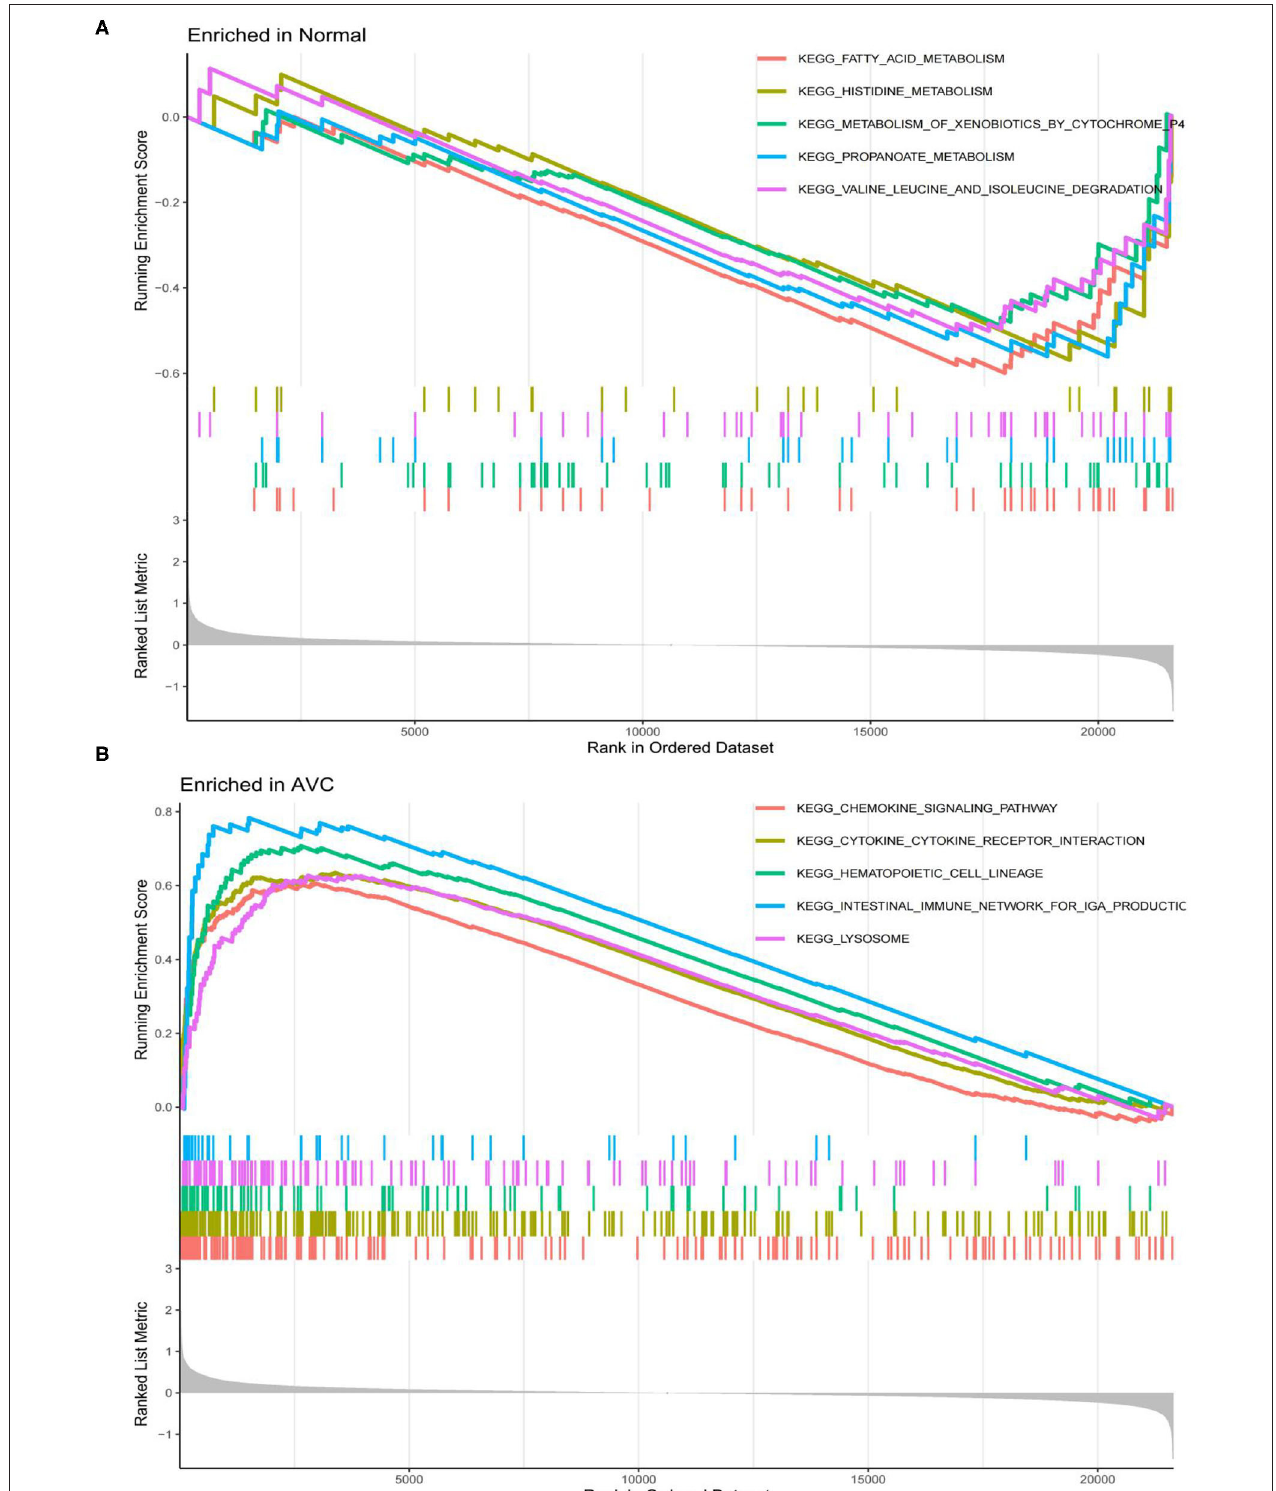
FIGURE 6 | Analysis of the top 4 Kyoto Encyclopedia of Genes and Genomes (KEGG) pathway terms for all genes enriched in the normal and AVC groups using Gene set enrichment analysis (GSEA). (A) Analysis of the KEGG pathway terms for all genes enriched in the normal group using GSEA. (B) Analysis of the KEGG pathway terms for all genes enriched in the AVC group using